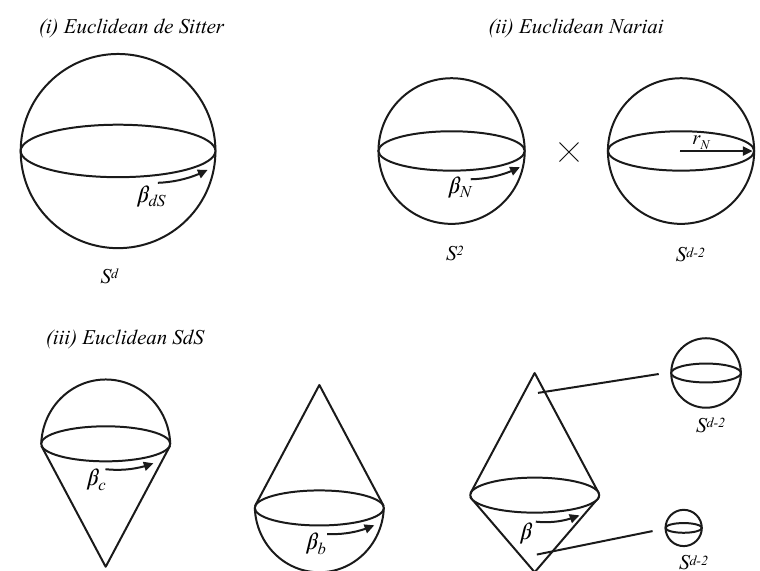
Figure 4: Euclidean SdS geometry. (i) Euclidean de Sitter space is a sphere S d and = 2 π L . (ii) Euclidean Nariai space is the Euclidean time circle has periodicity β (cid:112) dS = 2 π L / S 2 × S d − 2 , where the S 2 has a Euclidean time circle with periodicity β d − 1 N and the S d − 2 has radius r . (iii) Euclidean SdS space is a warped product of S 2 , with N one or two conical defects, times S d − 2 . We have drawn three possible Euclidean SdS geometries (“ice cream cones”): on the left we removed the conical singularity at the = 2 π/κ cosmological horizon by fixing the Euclidean time periodicity to be β , in c c the middle we removed the conical singularity at the black hole horizon by fixing the = 2 π/κ periodicity to be β , and on the right both conical singularities are present b b since the periodicity β is arbitrary. For these three geometries the radius of the S d − 2 varies along spatial sections, with the minimal (maximal) sphere corresponding to the black hole (cosmological)